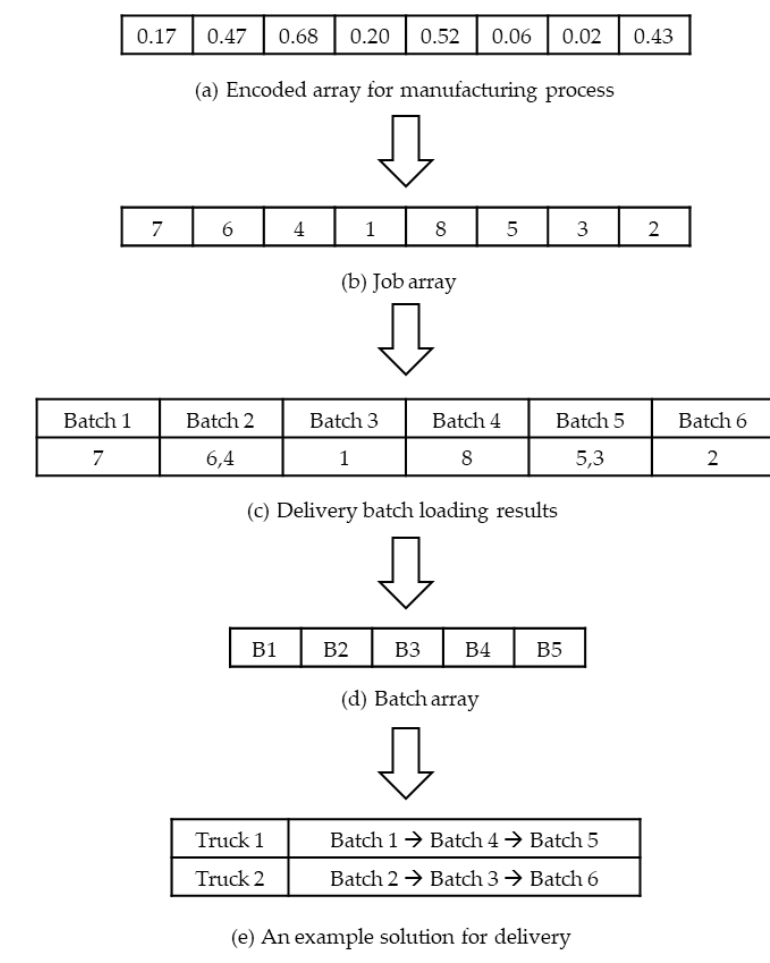
Figure 3. An example of decoding procedure for delivery.